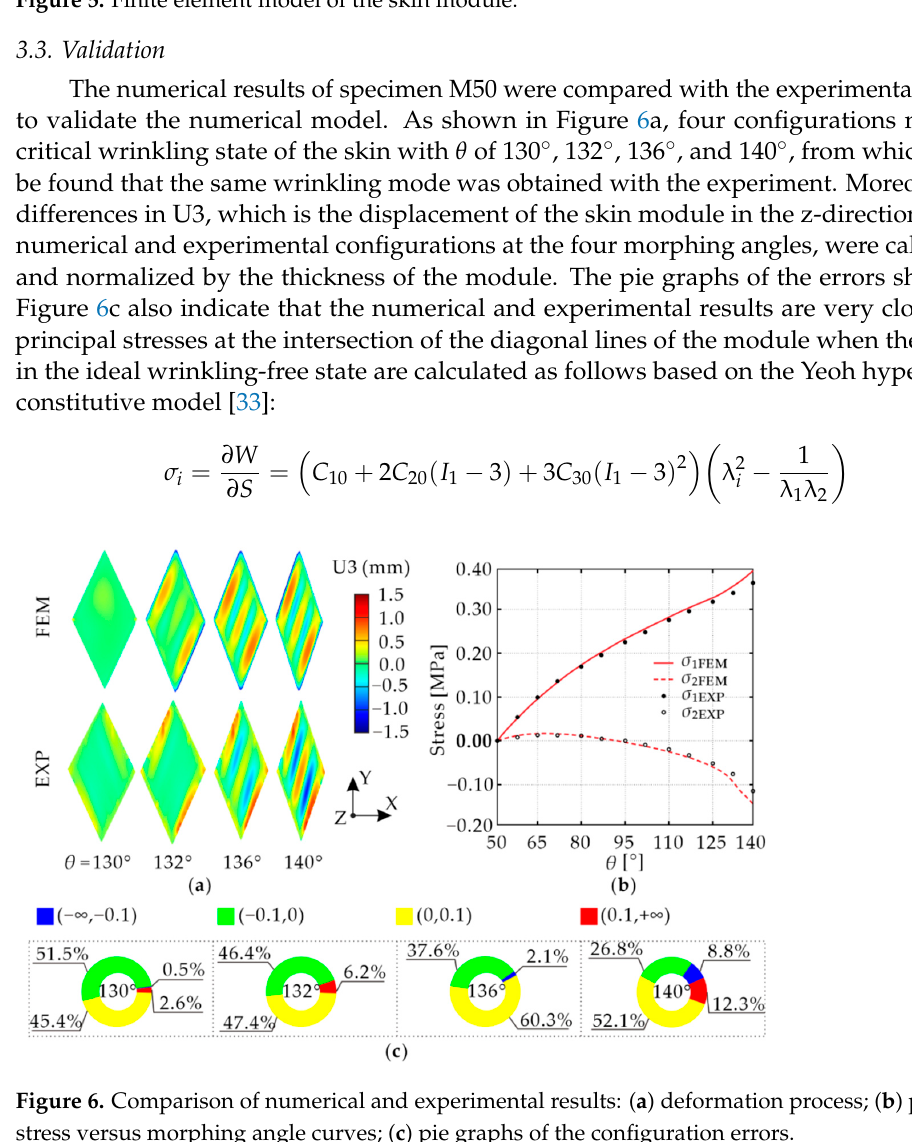
Figure 7. Deformation mode of the skin. 4. Results 4.1. Comparison of Standard and Angled Skin Modules To understand the deformation mechanism in more detail, numerical models were established, as outlined in this section. The effectiveness of the initial angle is presented here by comparing the standard model θ 0 = 90° as proposed in reference [31] and the an- gled one θ 0 = 50°. The numerical deformation processes of the two models are shown in Figure 8a. Moreover, the maximal and minimal principal stresses, σ 1 and σ 2 , at the inter- section point are extracted from the numerical and theoretical models and drawn against the morphing angled θ in Figure 8b,c, respectively. The deformation of model θ 0 = 90° is first analyzed to explore the deformation mech- anism. Since the deformation below 90° is the mirror image of that above 90°, only the branch above 90° is considered. As the morphing angle θ increases, the compressive stress